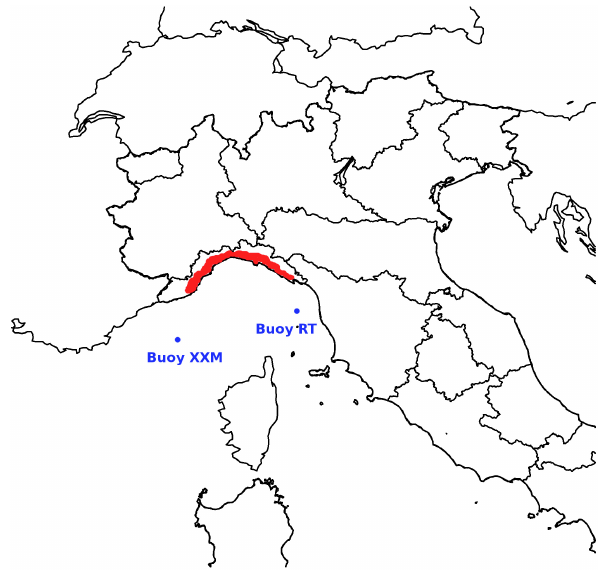
Figure 1. Detailed map of the Ligurian sea and coastlines, where red line describes the area of main coastal damages. Blue dots show the location of the two moored buoys used in the study, the Ven- timiglia (XXM) and Tuscany Region one